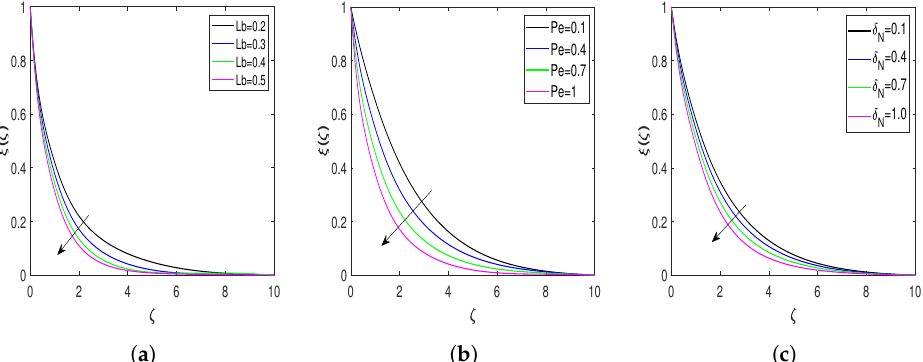
Figure 7. Distribution of microorganisms for different flow parameters. ( a ) Microorganism distribu- tion for Lb ; ( b ) Microorganism distribution for Pe ; ( c ) Microorganism distribution for δ N